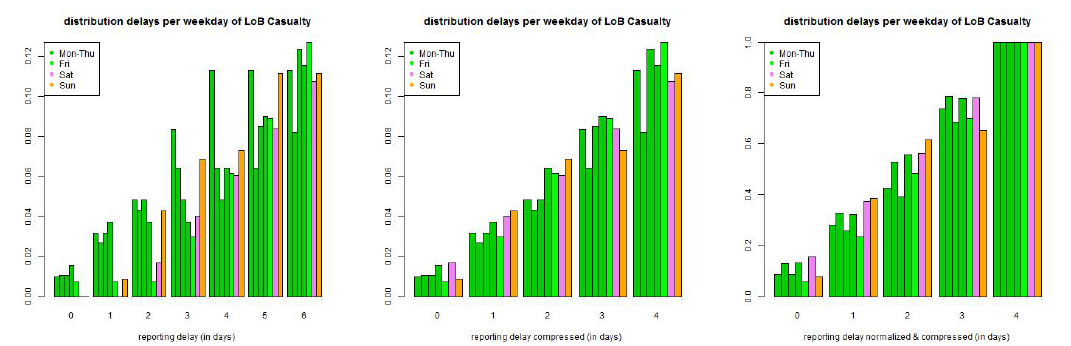
Figure 6. (top) LoB Property and (bottom) LoB Casualty: empirical distribution of reporting delays separated by weekdays of claims occurrence of all data with accident date prior to 01/2006 and maximal reporting delay of U (cid:96) ≤ 365 days (lhs) per day, (middle) compressed by weekends, and (rhs) compressed and normalized to 1 after a delay of one